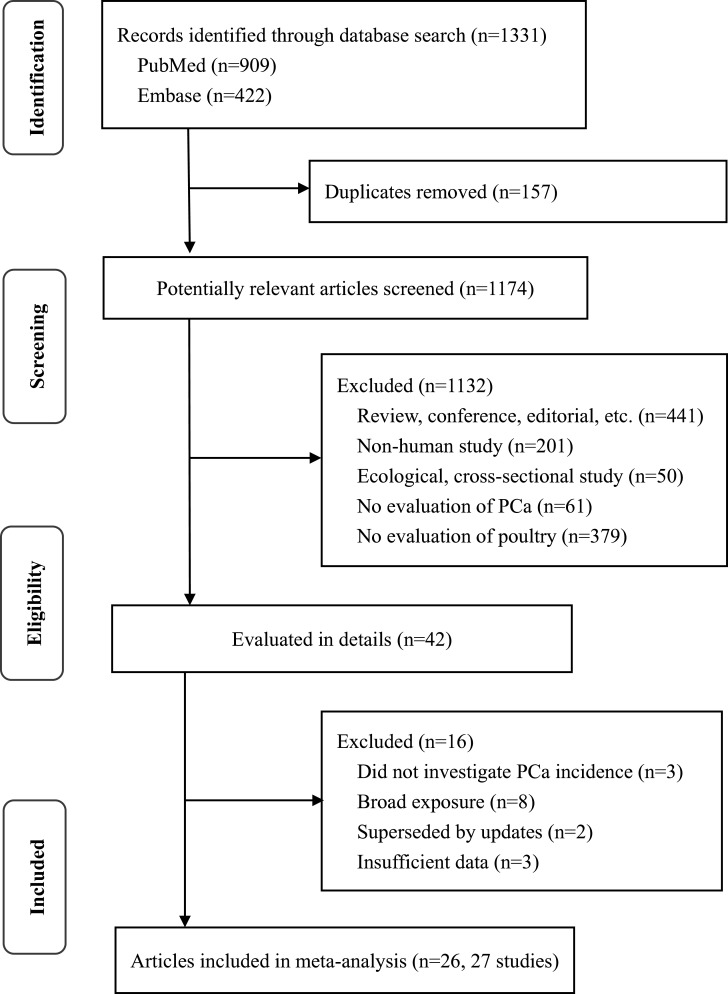
Flowchart of the literature search.